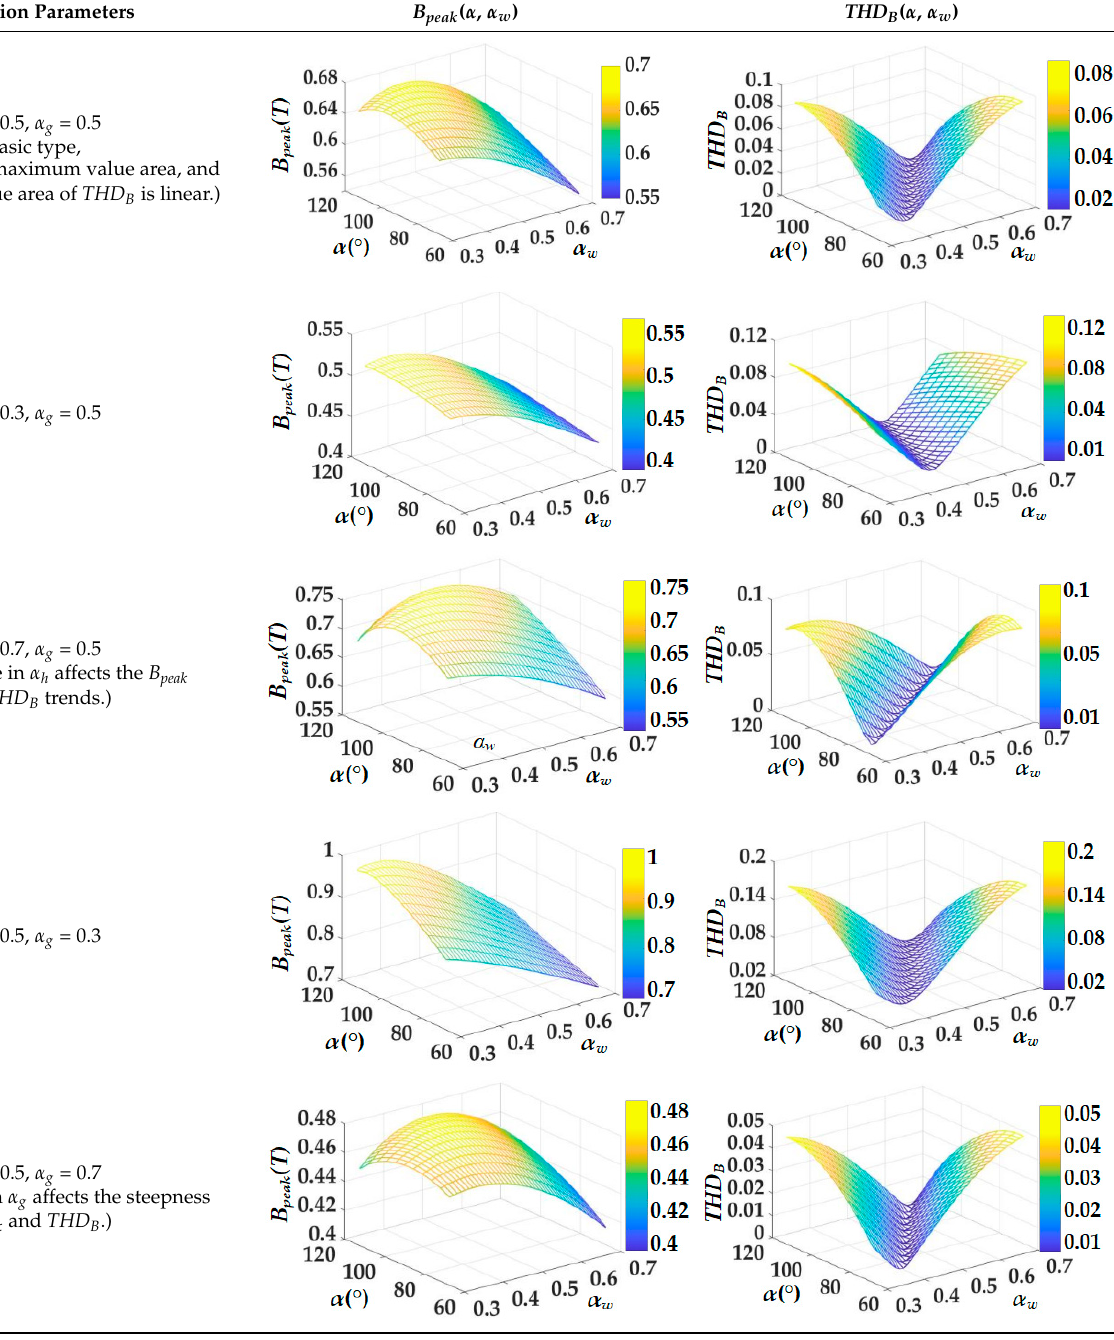
Table 3. Analysis of the influence rule of α and α w on B peak ( α , α w )and THD B ( α , α w ) of the central Table 3. Analysis of the in fl uence rule of α and α w on B peak ( α , α w )and THD B ( α , α w ) of the central Table 3. Analysis of the in fl uence rule of α and α w on B peak ( α , α w )and THD B ( α , α w ) of the central Table 3. Analysis of the in fl uence rule of α and α w on B peak ( α , α w )and THD B ( α , α w ) of the central Table 3. Analysis of the in fl uence rule of α and α w on B peak ( α , α w )and THD B ( α , α w ) of the central Table 3. Analysis of the in fl uence rule of α and α w on B peak ( α , α w )and THD B ( α , α w ) of the central Table 3. Analysis of the in fl uence rule of α and α w on B peak ( α , α w )and THD B ( α , α w ) of the central Table 3. Analysis of the in fl uence rule of α and α w on B peak ( α , α w )and THD B ( α , α w ) of the central magnetic fi eld of the air Table 3. Analysis of the in fl uence rule of α and α w on B peak ( α , α w )and THD B ( α , α w ) of the central magnetic fi eld of the air gap. magnetic field of the air gap. Table 3. Analysis of the in fl uence rule of α and α w on B peak ( α , α w )and THD B ( α , α w ) of the central Table 3. Analysis of the in fl uence rule of α and α w on B peak ( α , α w )and THD B ( α , α w ) of the central magnetic fi eld of the air gap. magnetic fi eld of the air gap. magnetic fi eld of the air gap. magnetic fi eld of the air gap. magnetic fi eld of the air gap. magnetic fi eld of the air gap. magnetic fi eld of the air gap. magnetic fi eld of the air gap.